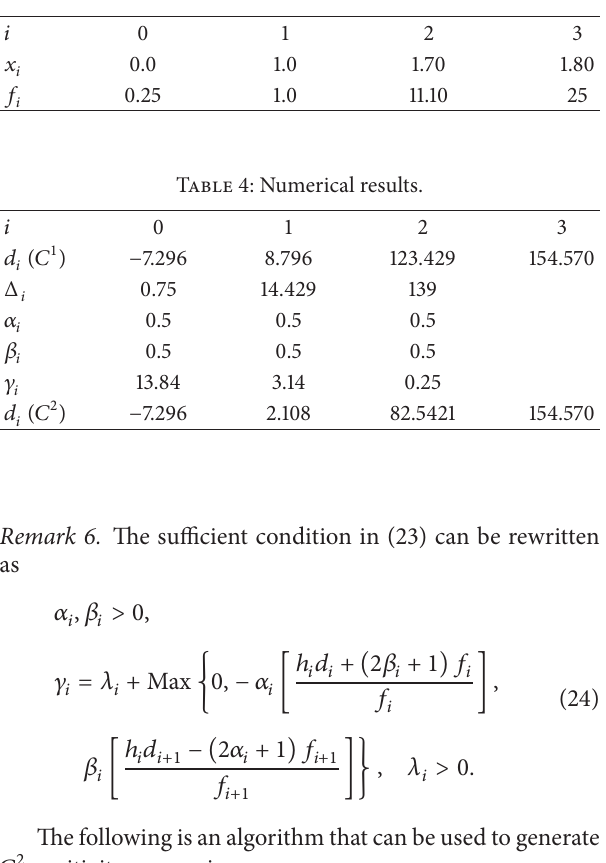
Table 5: A Positive data from work by Sarfraz et al. [28].